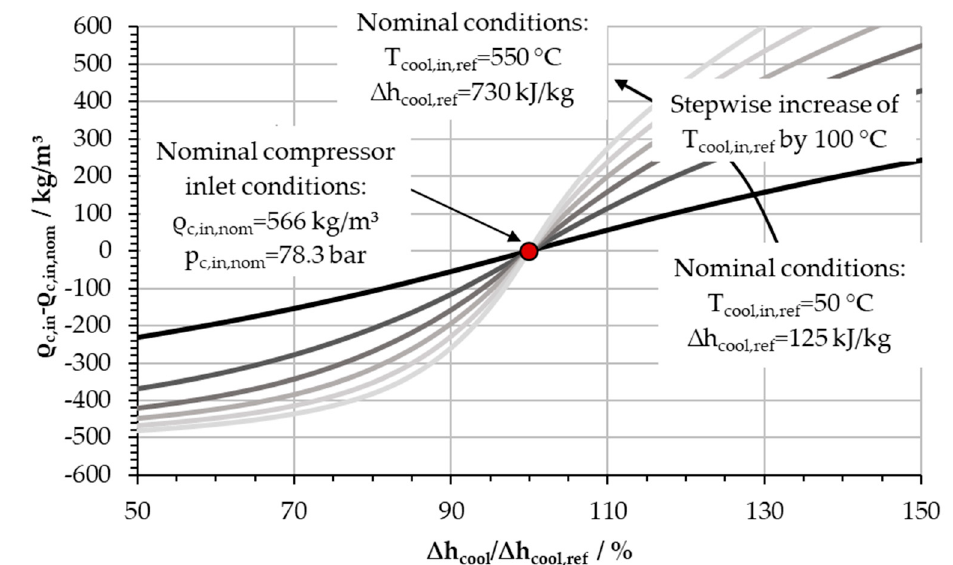
Figure 9. Change of compressor inlet density by varying cooler inlet conditions.